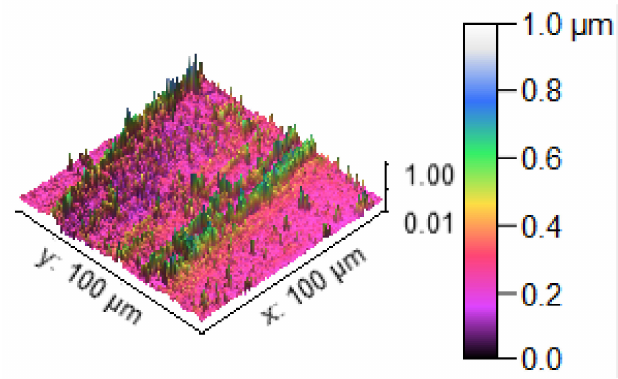
Figure 13. Three dimensional (3D) profilometric image (S-1).